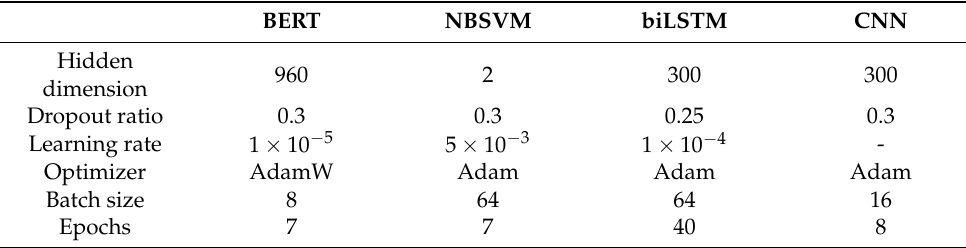
Table 4. Parameters of the models.